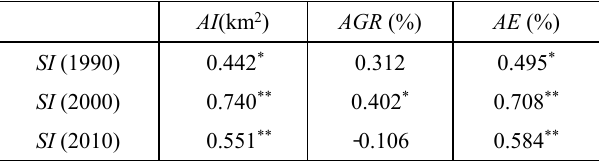
Table 4. Spearman's rank correlation coefficient between SI and urban expansion